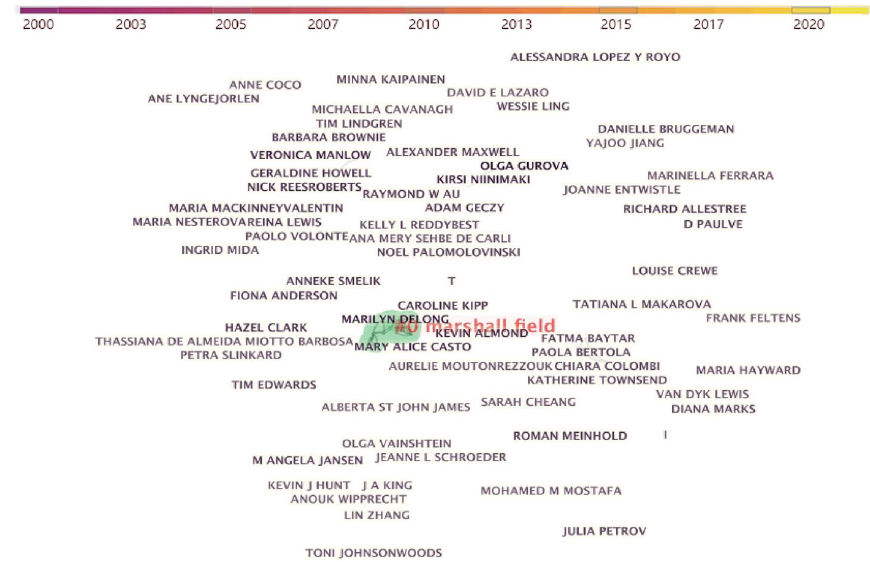
Fig. 2 Author collaboration